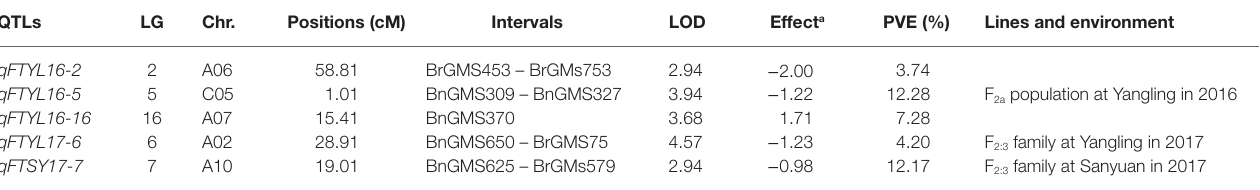
TABLE 2 | QTL for flowering time identified basing on SSR genetic